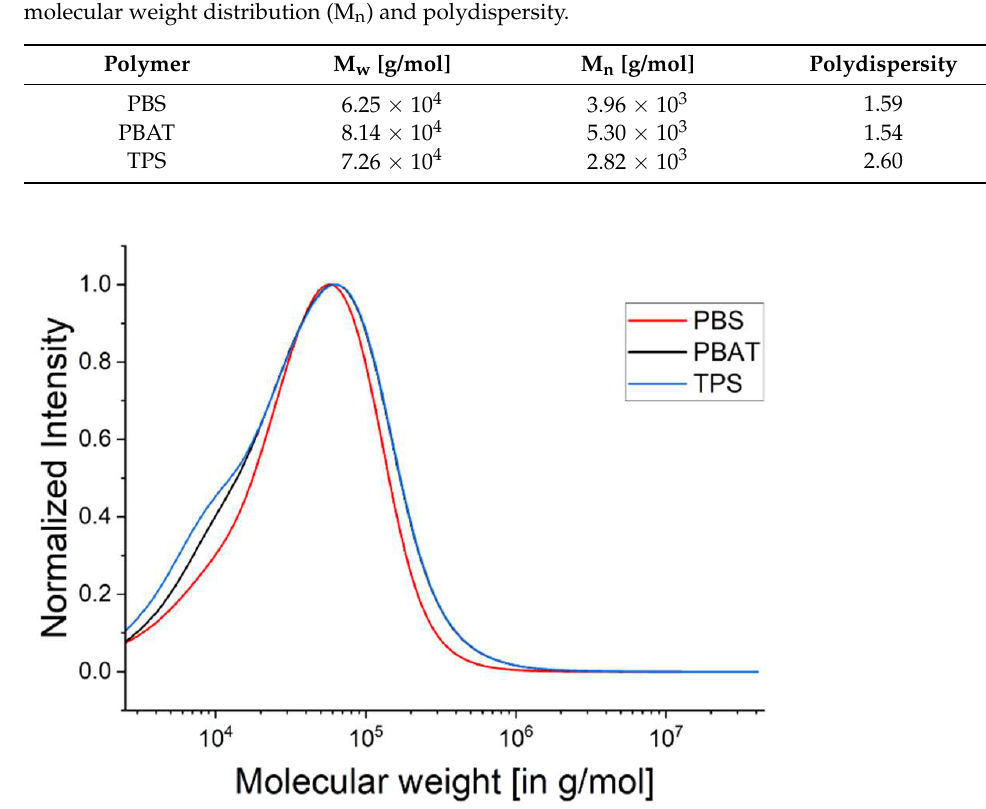
Table 5. GPC analysis of three biopolymers after rheology to determine the molecular weight (M w ), molecular weight distribution (M n ) and polydispersity.